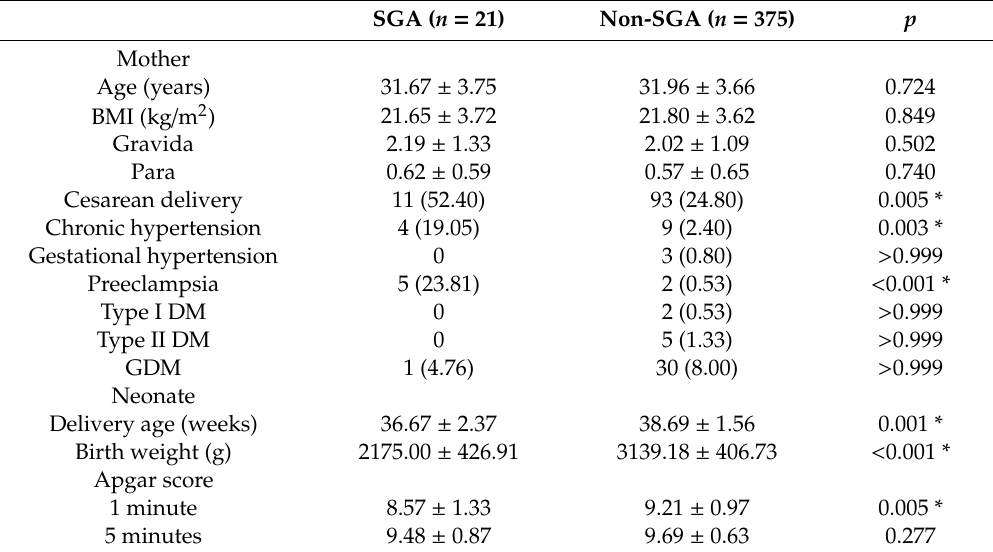
Table 1. Maternal characteristics and neonatal